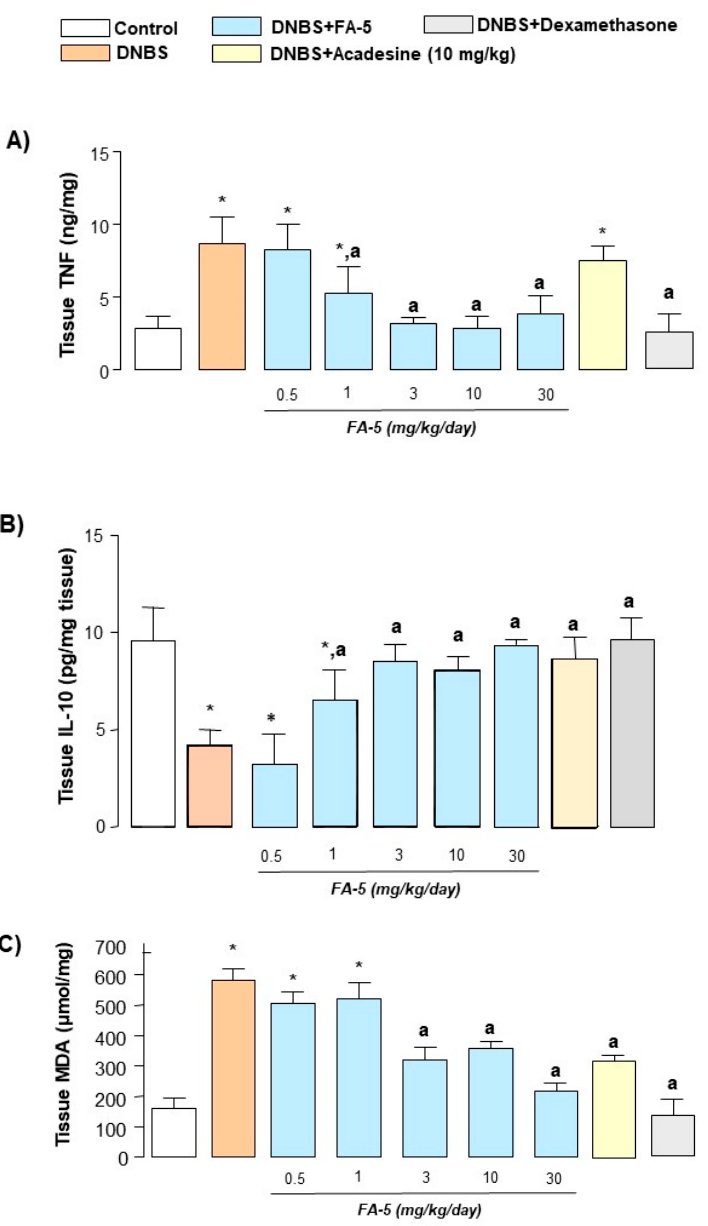
Figure 7. TNF ( A ), IL-10 ( B ), and MDA ( C ) levels in colonic tissues from control rats or in animals treated with DNBS either alone or in combination with FA5 (0.5, 1, 3, 10, 30 mg/kg/day), acadesine (10 mg/kg/day), or dexamethasone (0.1 mg/kg/day). Each column represents the mean ± standard error of the mean (SEM) ( n = 8). *, p < 0.05, significant difference versus control group; a , p < 0.05, significant difference versus DNBS group.